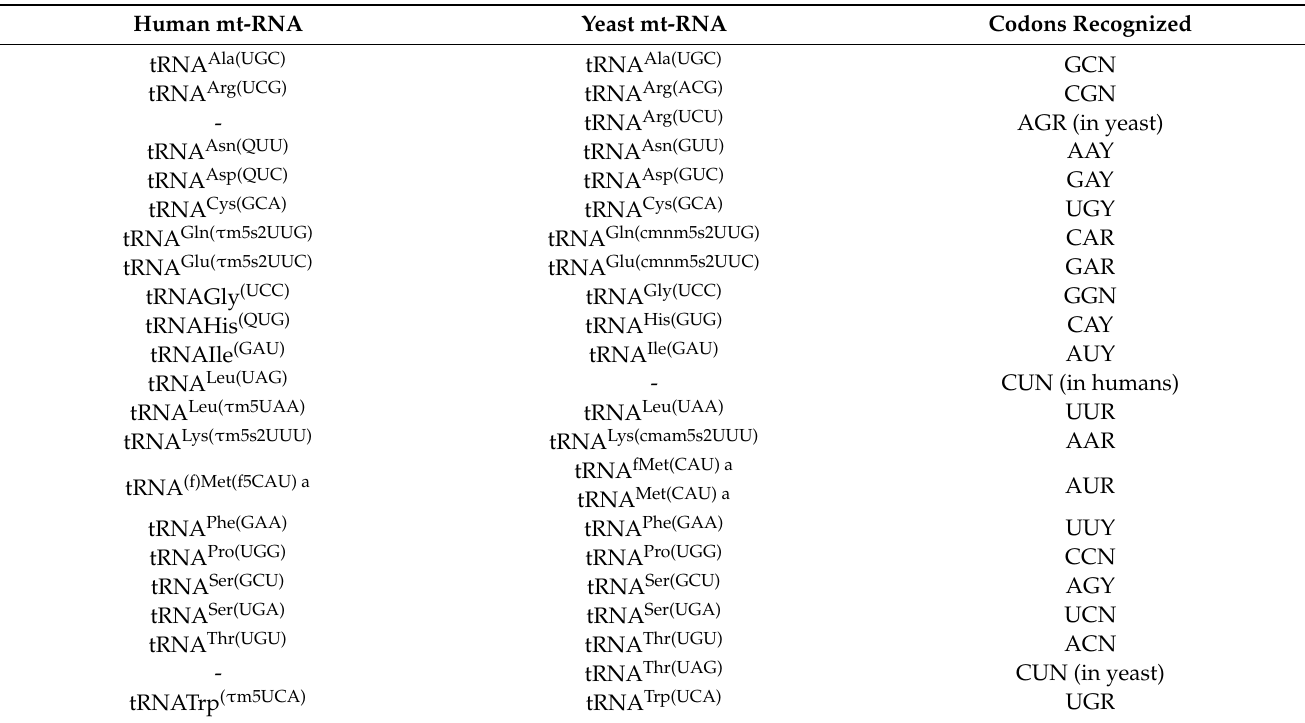
Table 4. Human mt-tRNAs with their anticodon with modifications according to [21], and their yeast corresponding mt-tRNAs with their anticodon with modifications according to [28], and the recognized codons; human mt-rRNAs and their corresponding yeast mt-rRNAs. Human mt-RNA Yeast mt-RNA Codons